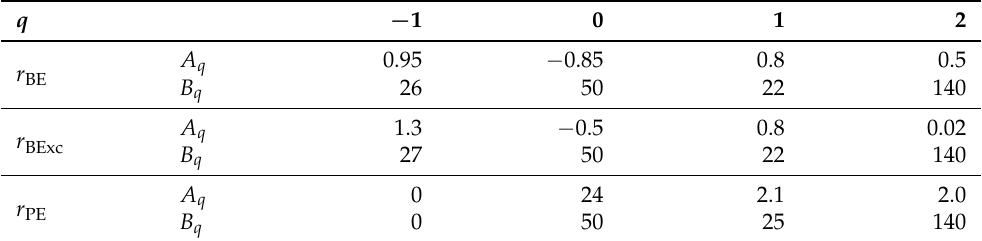
Table 3. Single band BER fit coefficients.